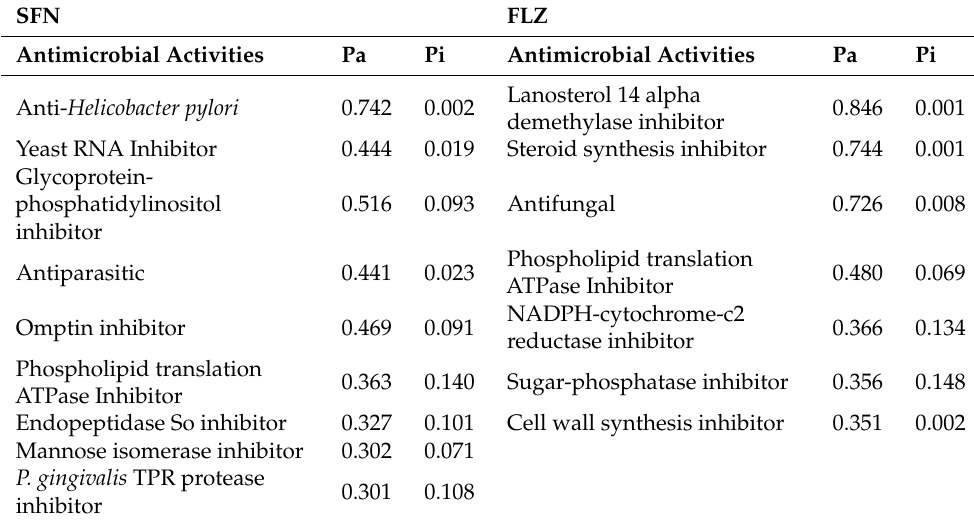
Table 1. In silico identification of the antimicrobial activities of sulforaphane (SFN) and fluconazole (FLZ).